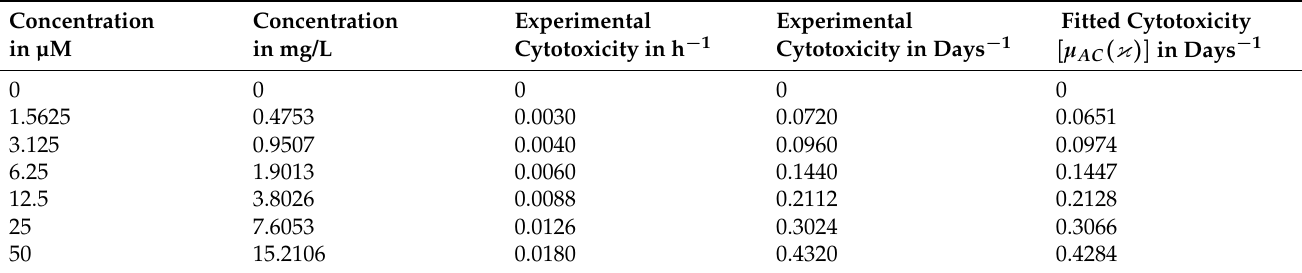
Table 2. Chlorambucil concentration and its computed and approximated cytotoxicity rates ( µ AC ) on leukemia cancer cells. Data from columns ‘Concentration in µM’ and ‘Experimental cytotoxicity in h − 1 ’ were extracted from Appendix A in Guzev et al.